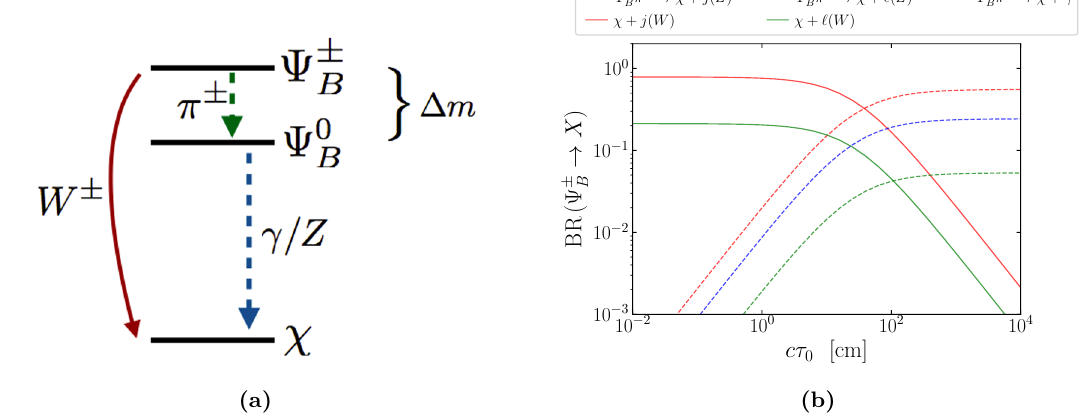
Figure 13. Typical decay processes of the singlet-triplet model (left). Charged mediator branching ratio to the products listed in the legend as a function of the neutral mediator decay length cτ a proxy for the scale Λ for a mediator mass m